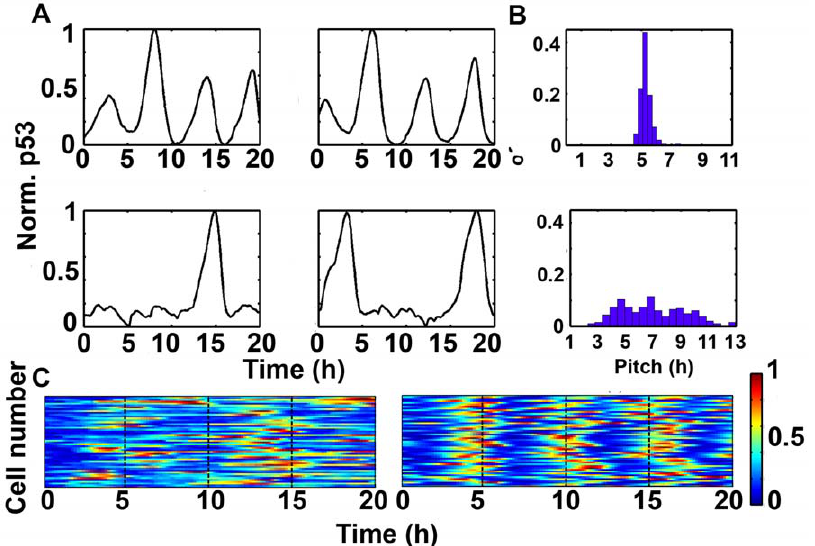
Figure 5. Stochastic p53 dynamics under stressed and nonstressed conditions. (A) Dynamics of p53 under stressed (top panels) and nonstressed condition (bottom panels). (B) Characteristic pitch distributions. Stressed (top), nonstressed (bottom). (C) 50 samples of p53 dynamics (normalized, left: nonstressed, right: stressed).